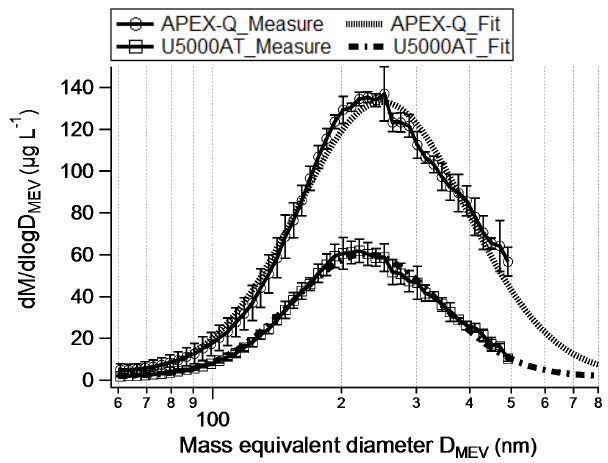
Figure 1. Mass size distributions of polydispersed AQ (100µgL − 1 ) measured with APEX-Q and U5000AT. The whiskers stand for one standard deviation. Histogram bin size is